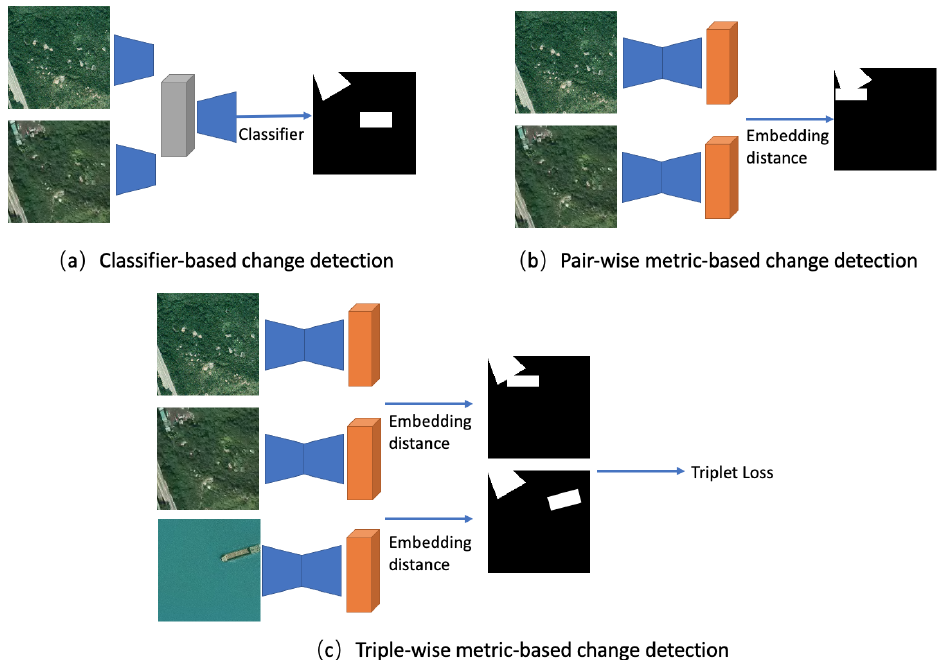
Figure 1. Illustration of classifier-based and metric-based change detection methods. ( a ) Traditional classifier-based change detection uses a classifier to output changed/unchanged regions. On the other hand, Metric-based methods use pixel-wise embedding distance as a metric, and the model training optimizes the embedding directly. ( b ) Pair-wise methods take paired images as input and compute contrastive loss. ( c ) Triple-wise methods take an additional image (the third row with different content) and have seldom been studied. How we use the extra image in triplet loss makes our method different from others. Details are explained in Section